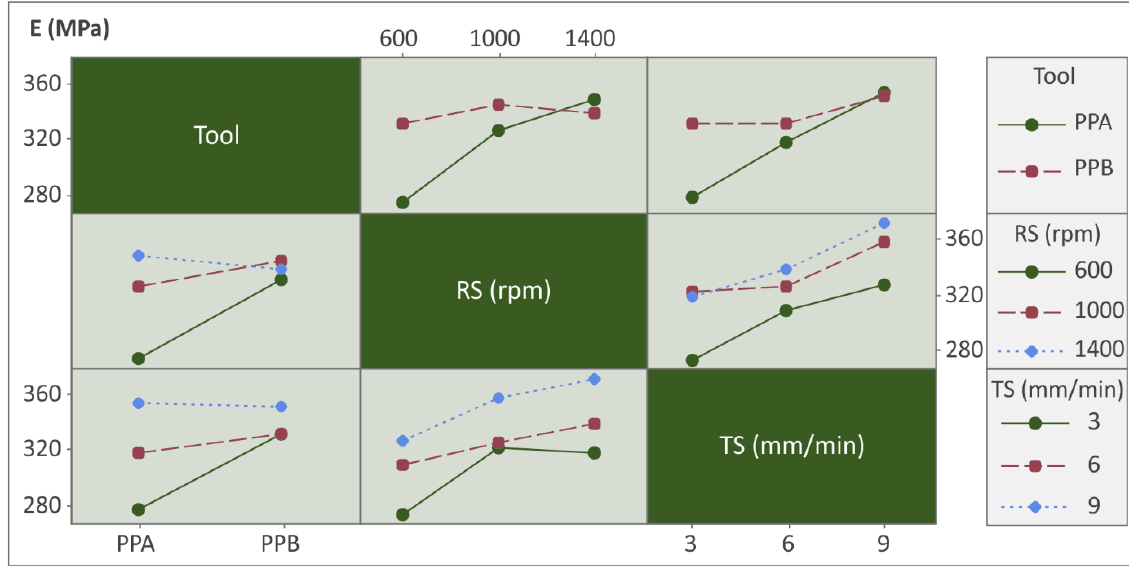
Figure 12. Interaction chart: Tool, RS, and TS vs. E.